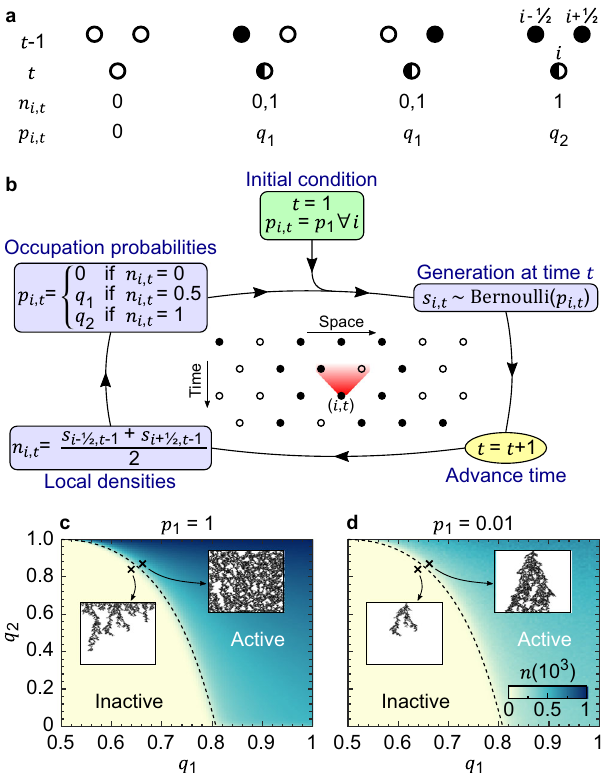
Fig. 1 Domany – Kinzel model of the directed percolation. a The probability p i to be occupied at time t depends on the occupation of its i , t of site nearest-neighbours i ± 1 at time t − 1 and can take discrete values 0, q 1 and 2 q 2 . b Flowchart representation of the DK model. The initial occupation probability is uniform p i , t = 1 = p 1 . At time t , each site i is either occupied ( s i , t = 1) or empty ( s i , t = 0) with probability p i , t and 1 − p i , t , respectively. Time is advanced and local densities f n i ; t g are computed for each site i as i averages of the nearest-neighbour occupations at previous time, and these densities determine the occupation probabilities for the next generation, see Eq. (3). The generations at all subsequent times are obtained by iteration. c , d The density n at late times can be used to discern the active and inactive phases, in which n ( t = 10 3 ) >0 and ≈ 0, respectively. The dashed lines serve as a reference to locate the phase boundary and are the same for initial densities p 1 = 1 ( c ) and p 1 = 0.01 ( d ). The insets show representative single instances of the DP for the points in the ( q 1 , q 2 ) plane marked with a cross. Here L = 100 and R = 10 3